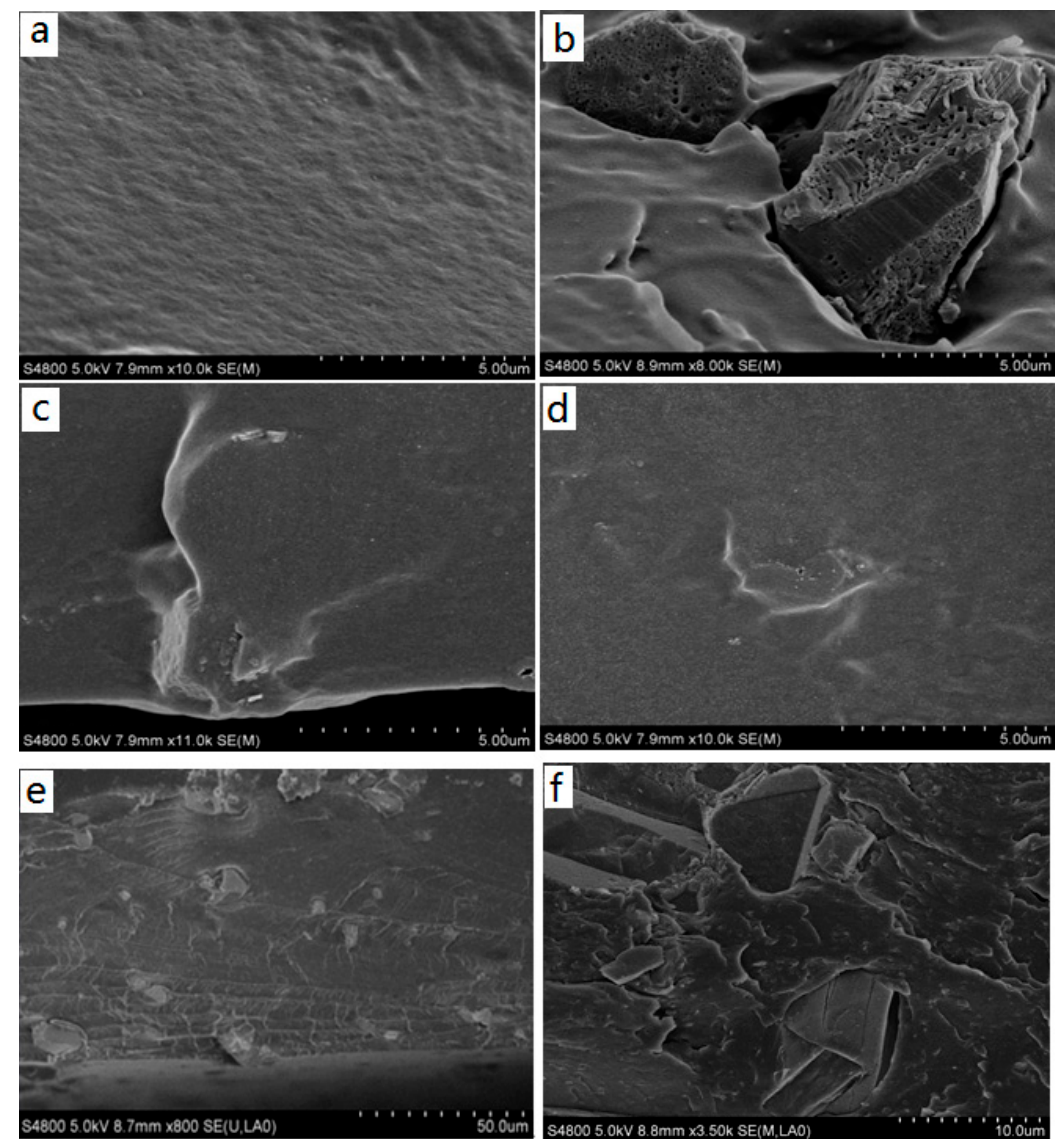
Figure 6. The SEM images of cross-section of ( a ) polyether-block-amide (Pebax) membrane, ( b ) Pebax/Cu-BTC mixed matrix membranes (MMMs) (3 wt.% MOF content in the MMMs), ( c